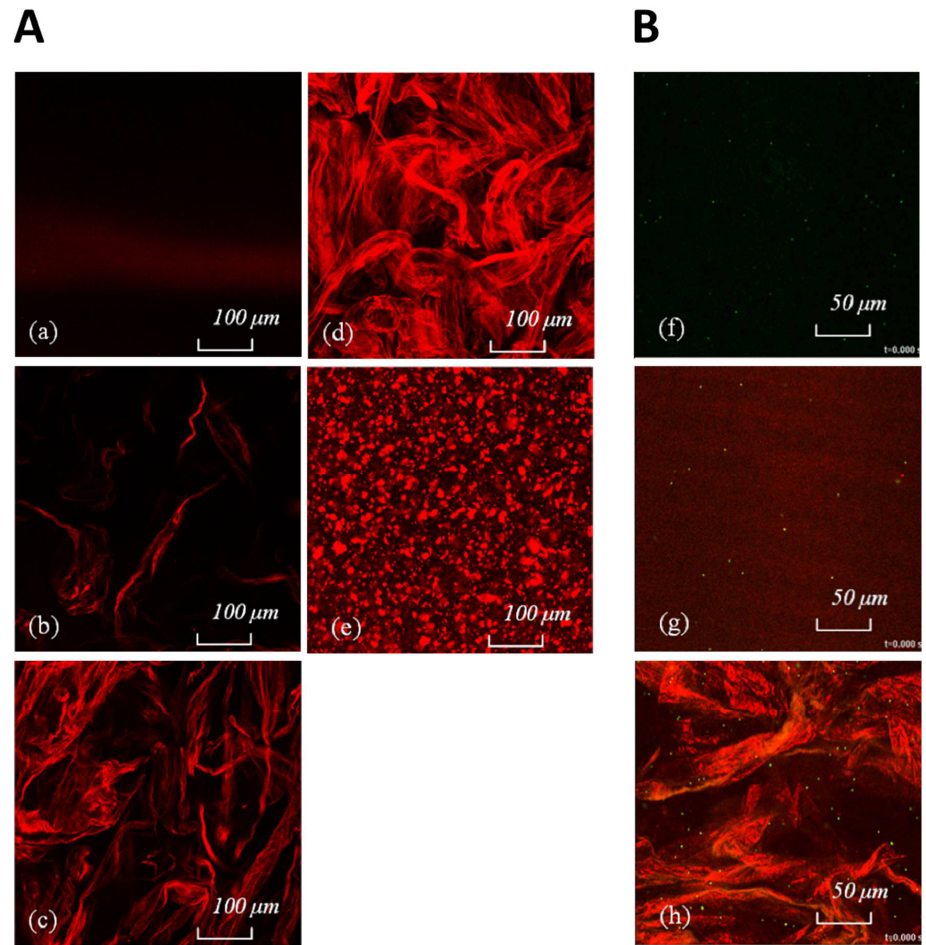
Figure 4. A . Confocal laser scanning microscopy (CLSM) images of ( a ) XLS suspension